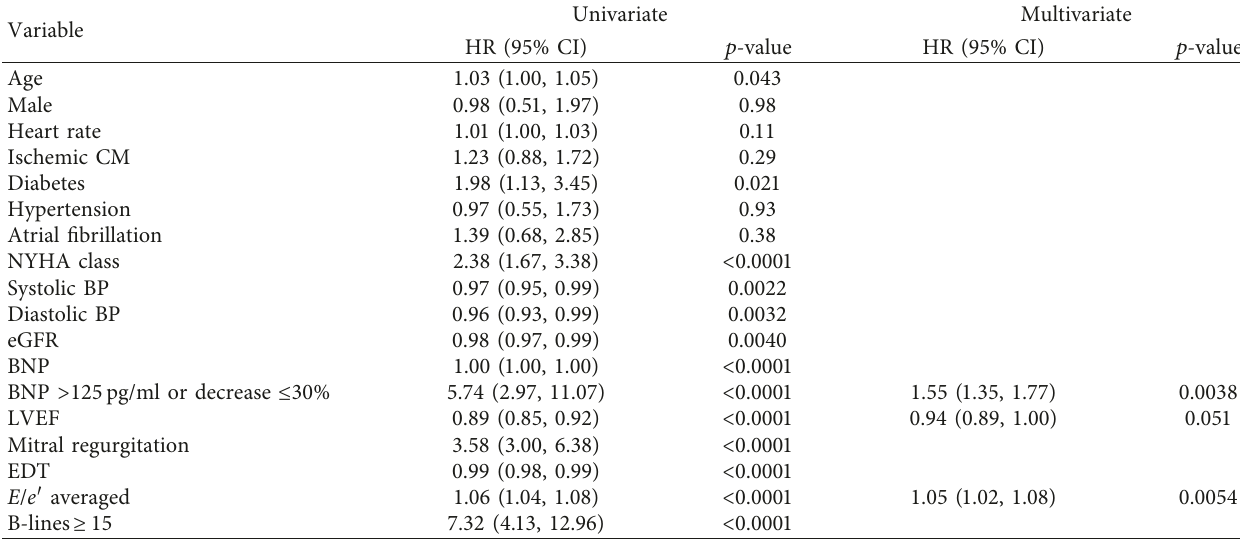
Table 2: Univariate and multivariate predictors of all-cause mortality among 224 patients of the BNP- and echo-guided group. Variable